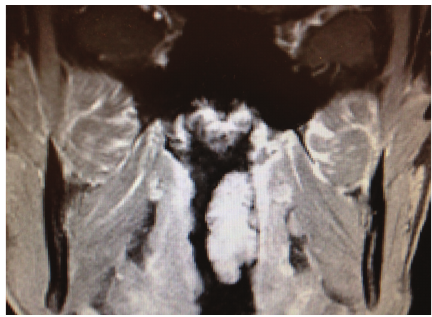
Figure 3: MRI coronal image demonstrating a pedunculated 3.1 ×